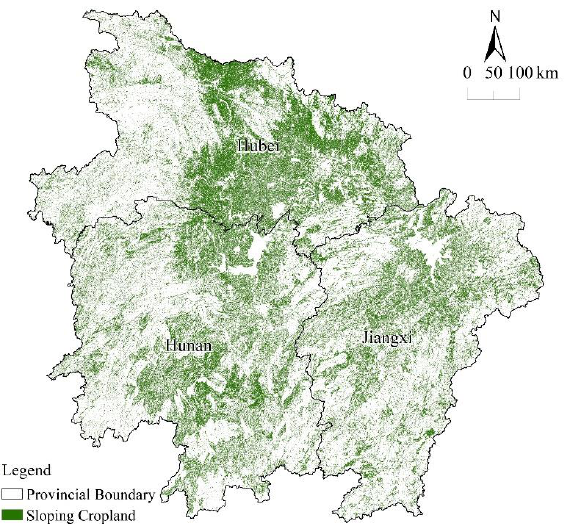
Figure 3. Distribution of sloping cropland in the MRYRR in 2020.